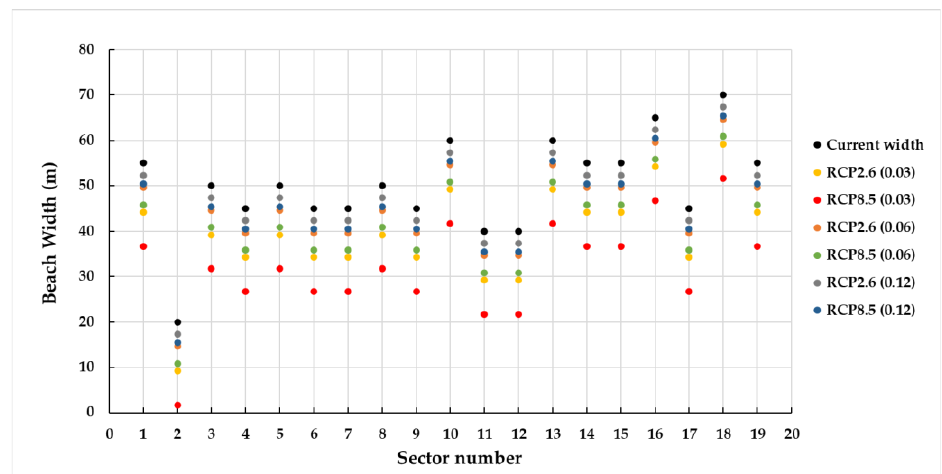
Figure 4. Beach widths (m) per sector considering the current and expected situation in 2100 for the representative concentration pathway (RCP)2.6 and RCP8.5 sea level rise (SLR) scenarios and coastal slopes 0.03, 0.06, and